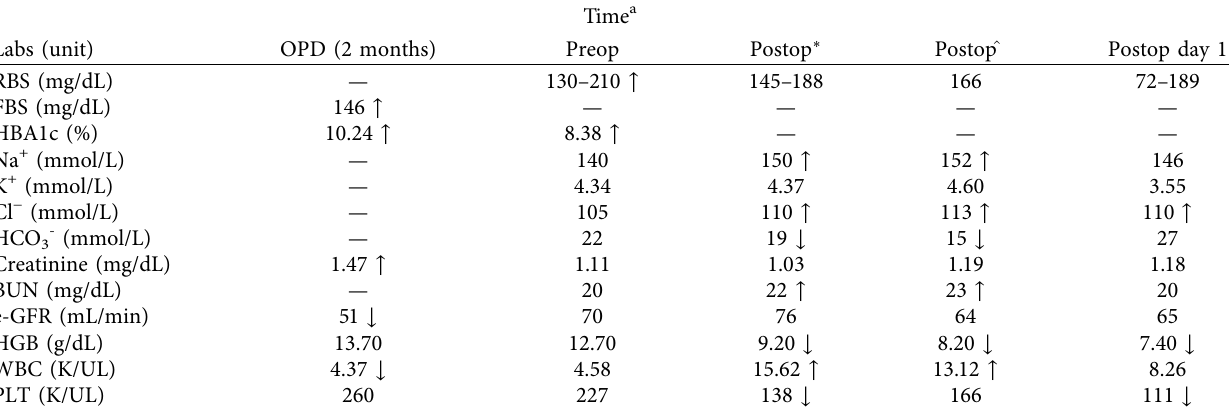
Table 1: Blood tests of our patient at 5 different occasions.